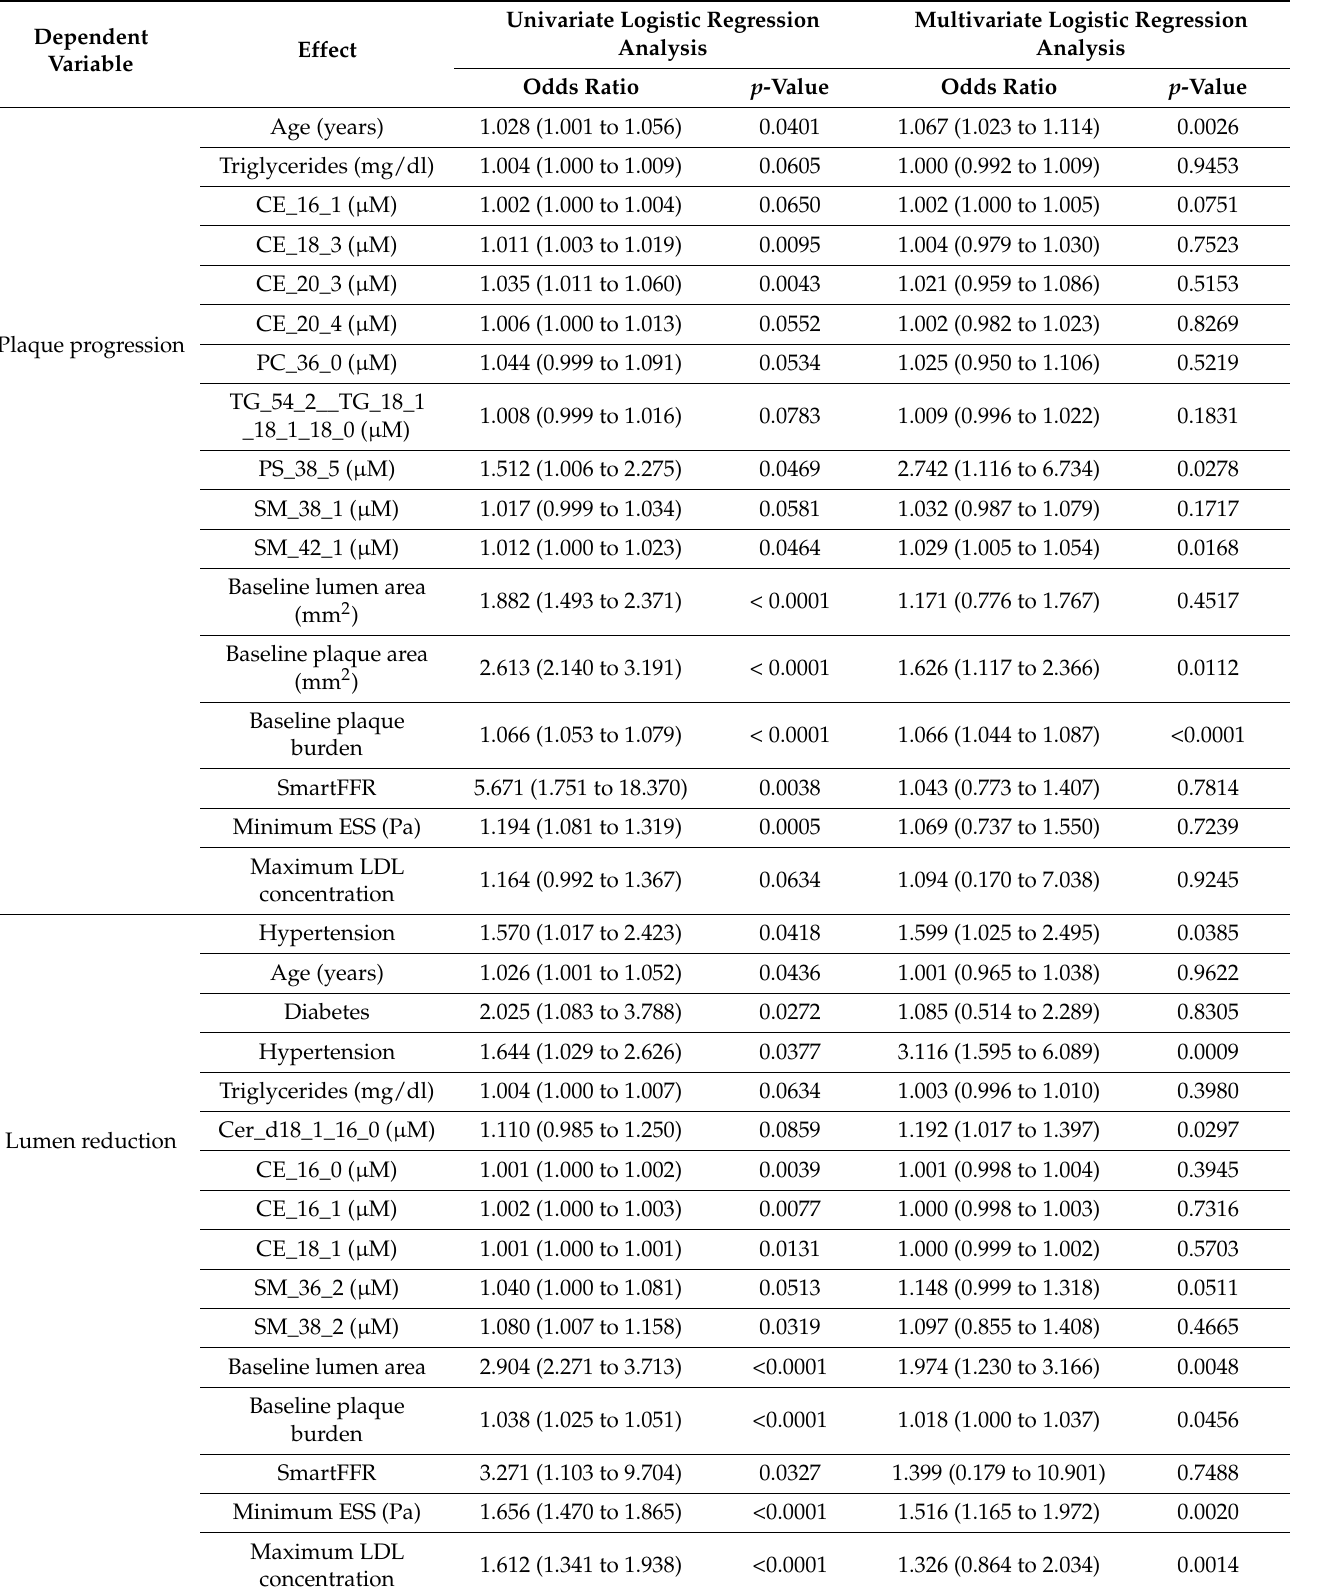
Table 5. Univariate and multivariate binary logistic regression analysis for the plaque progression and lumen area decrease.